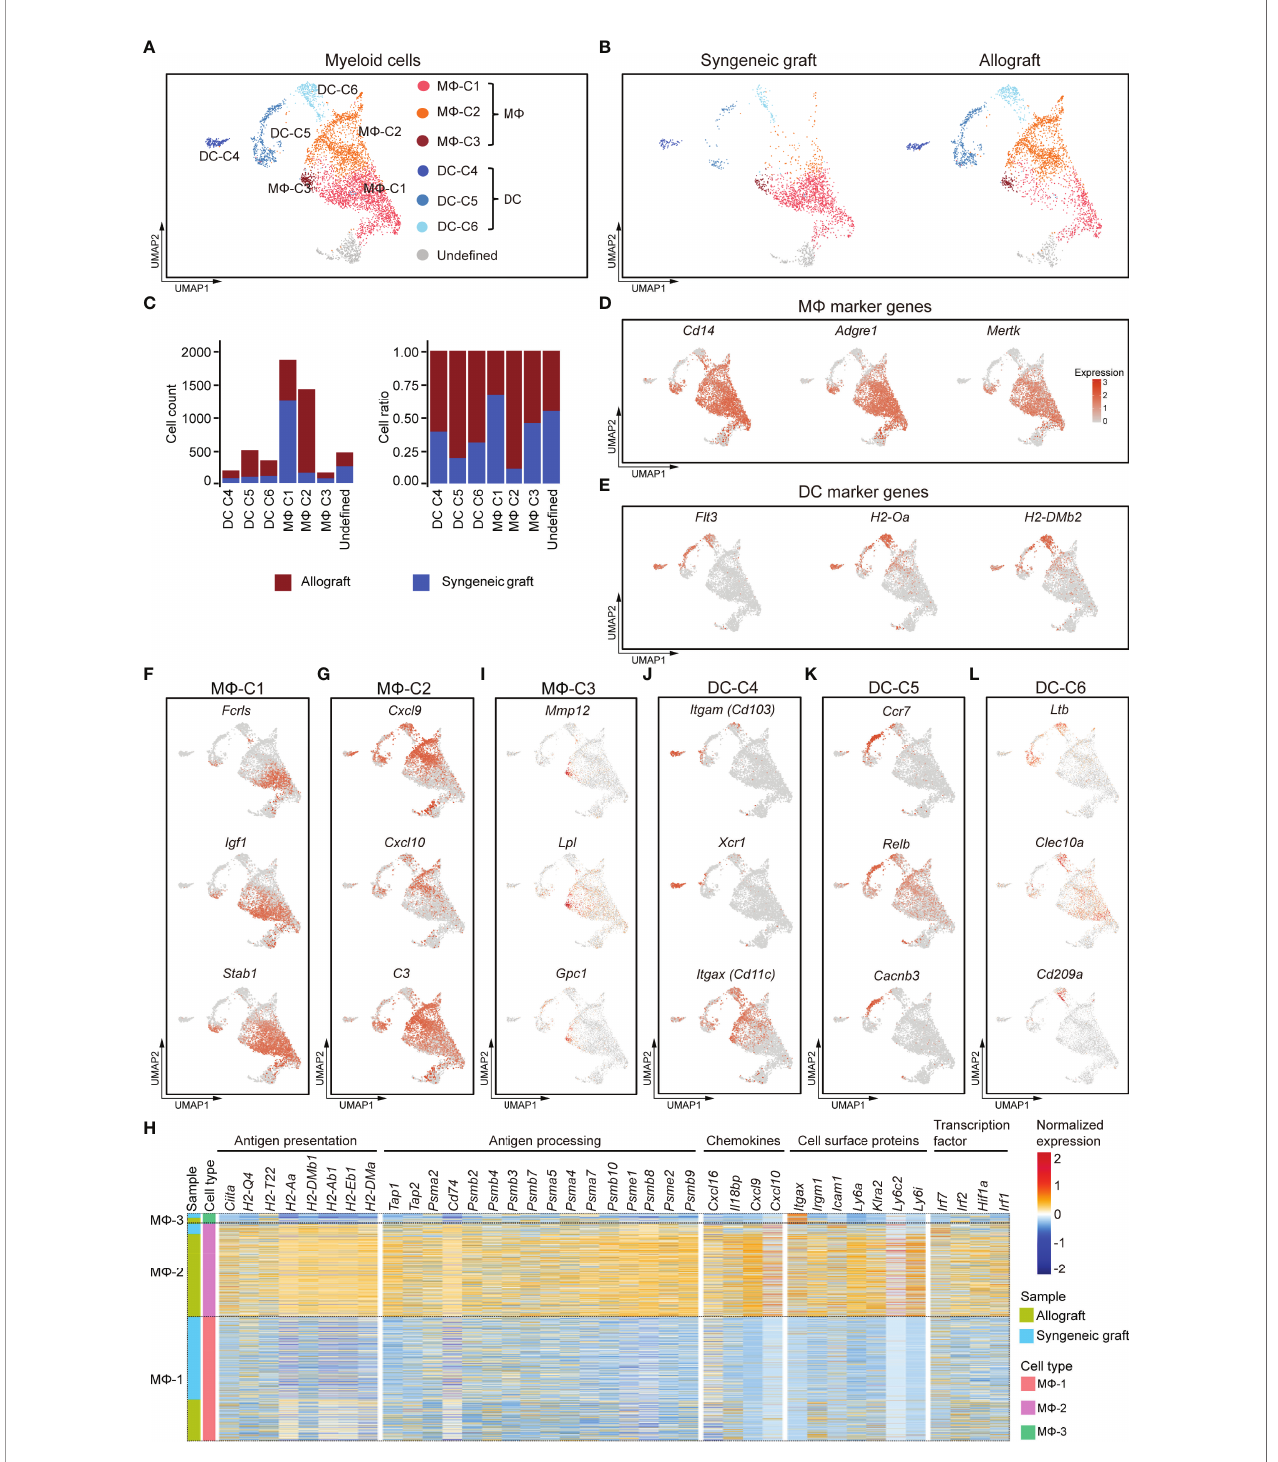
FIGURE 4 | Subclusters and molecular characteristics of myeloid cells in fi ltrated in islet grafts. (A) UMAP visualization of the total myeloid cells, with each cell colorcoded for the associated cell subtype. (B) UMAP visualization of myeloid cells from syngeneic grafts (left) and allografts (right), with each cell colorcoded for the associated cell type. (C) The number (left panel) and fraction (right panel) of cells in the indicated cell type. (D, E) UMAP visualization shows the expression of marker genes for macrophages (D) and DCs (E) . (F – I) UMAP visualization of the signature genes for 3 subclusters of macrophages: M F -C1 (F) , M F -C2 (G) , and M F -C3 (I) . (H) Heatmap showing row-scaled expression of representative genes within 3 subclusters of macrophages. Genes were categorized by their biological functions. Expression was measured in units of log2. (J – L) UMAP visualization of the signature genes for 3 subclusters of DCs: DC-C4 (J) , DC-C5 (K) , DC-C6 (L)